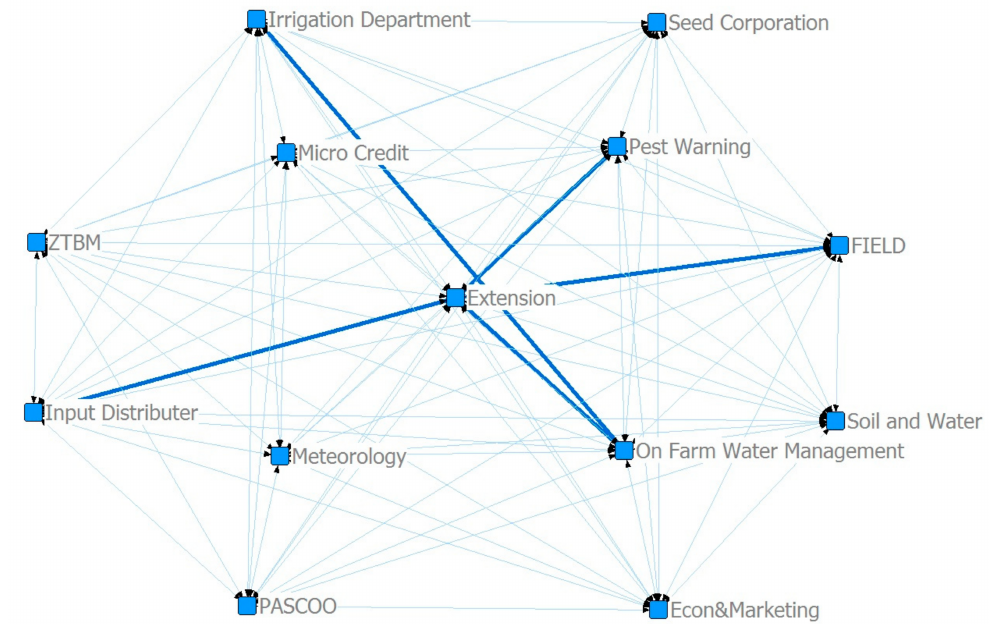
Figure 3. Connections and linkages between different institutions that provide on-farm services to farmers; bold blue lines represent active links while dim blue lines show missing or inactive links between different